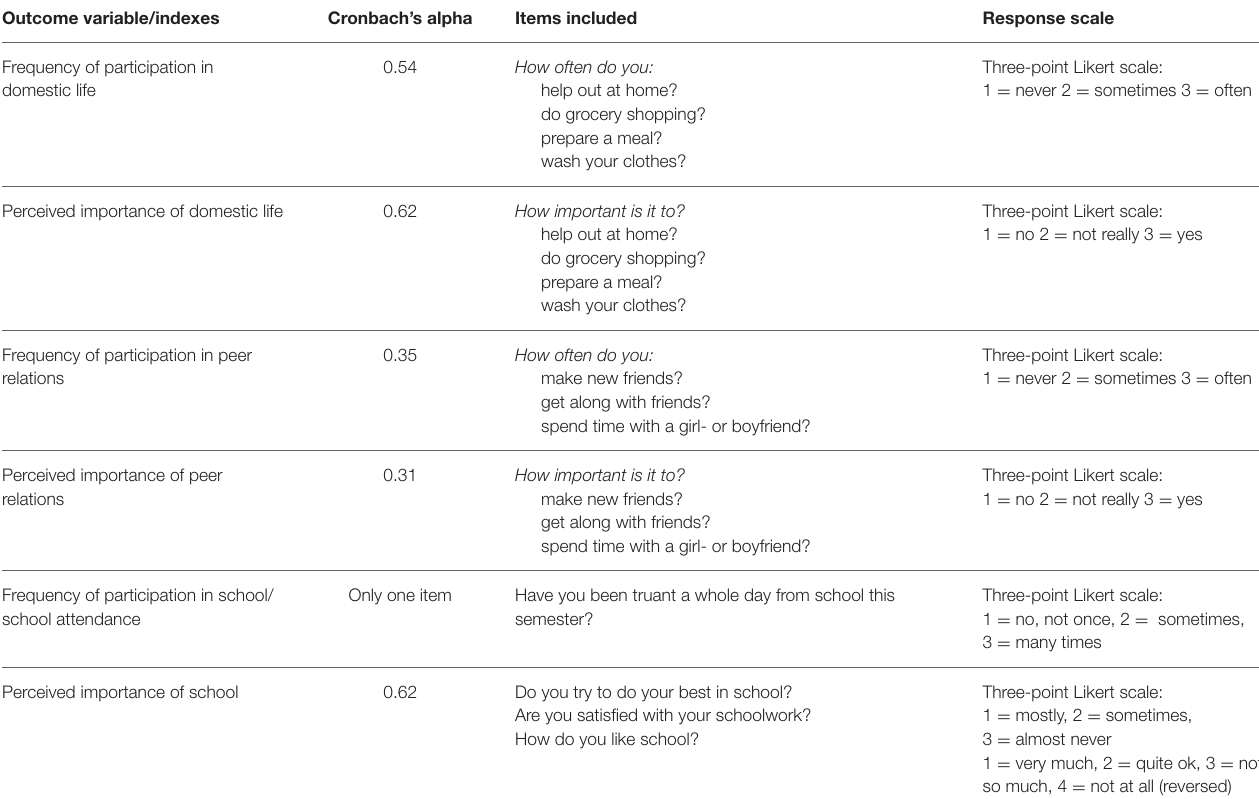
TABLE 1 | Overview of items in the dependent variables category. Outcome